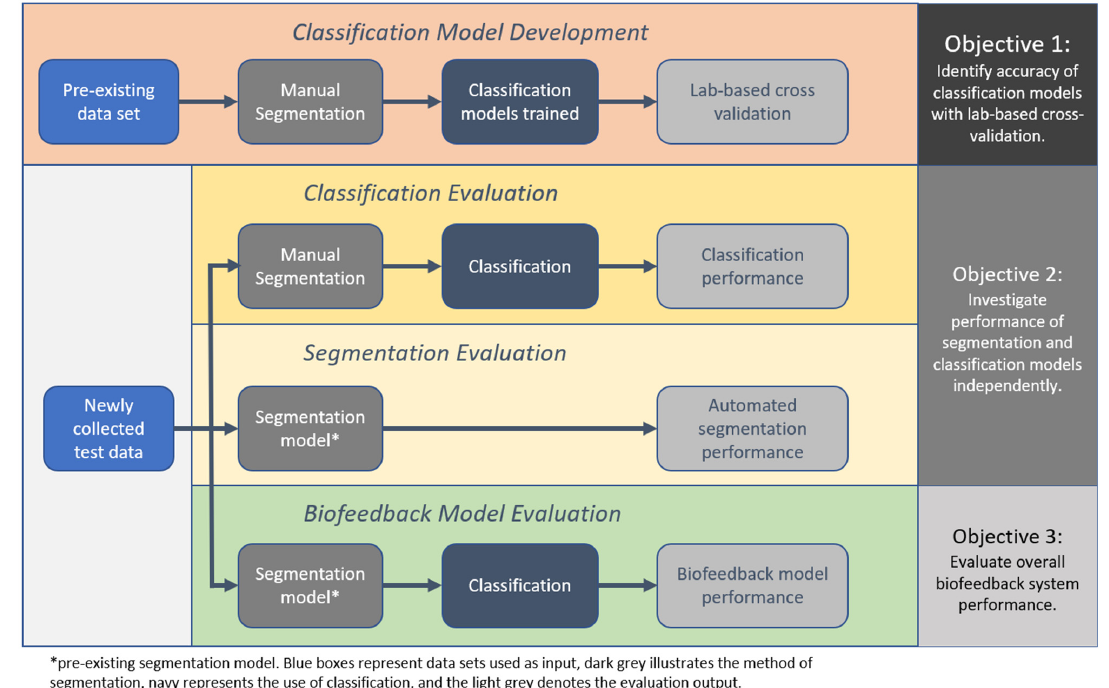
Figure 3. Steps of evaluation for the various machine learning components of the exercise biofeedback system.